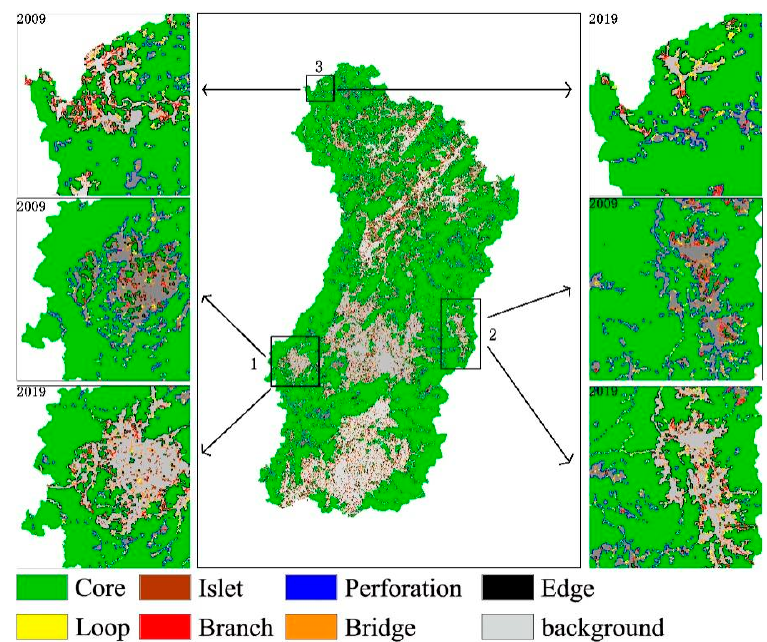
Figure 4. Spatial pattern of woodland MSPA for typical land types in Anyuan County, 2009-2019. Table 9. The area and proportion of MSPA classes in woodlands of Anyuan County (Unit: ha).